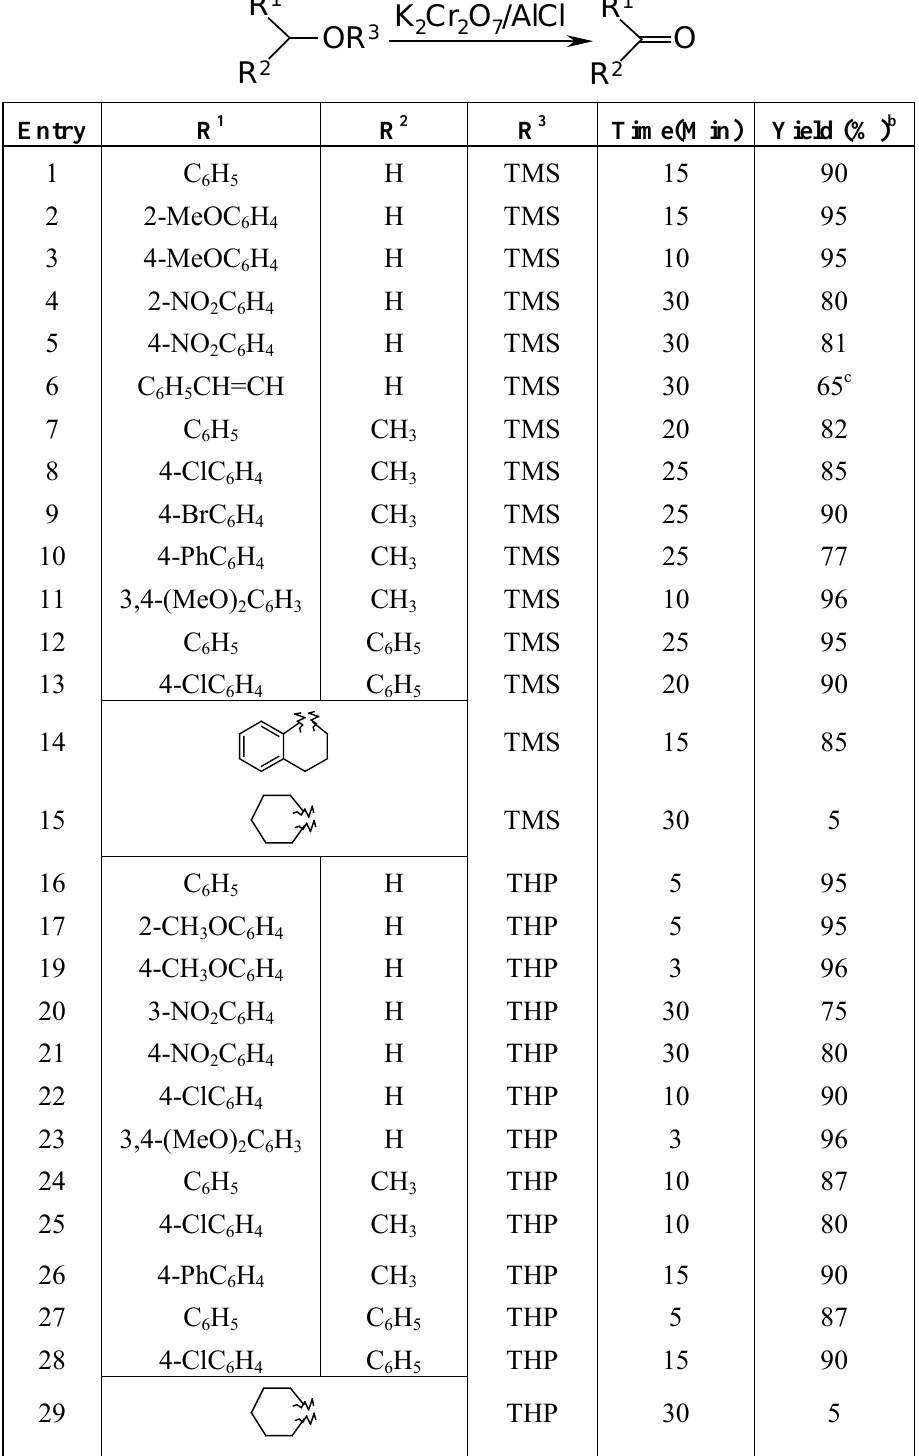
Table 4. Conversion of TMS and THP Ethers to Carbonyl Compounds